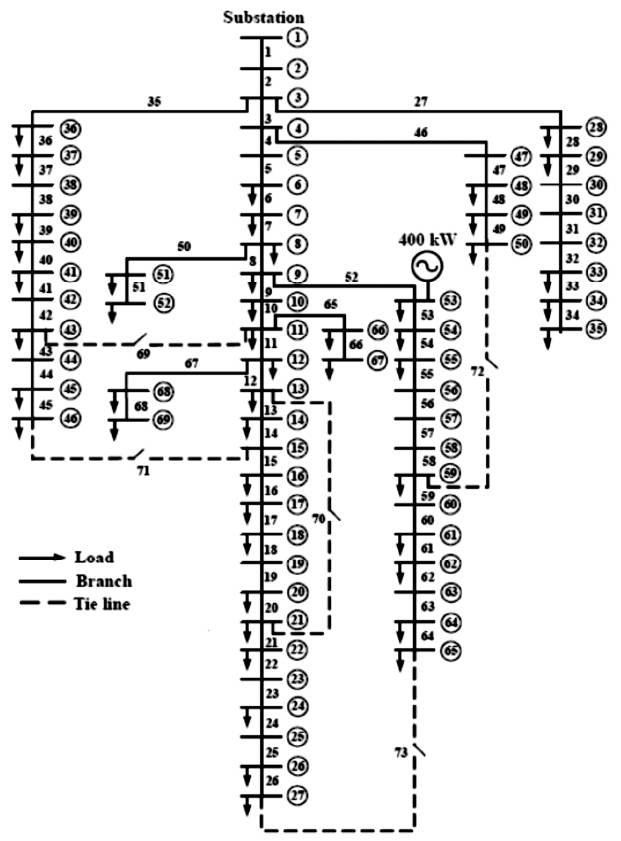
Figure 1. Tested 69 bus radial distribution system.